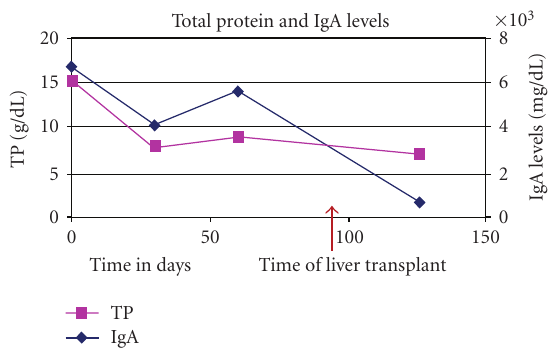
Figure 1: Total protein and IgA